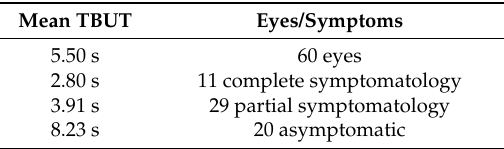
Table 4. Tear break-up time (TBUT) in eyes with or without